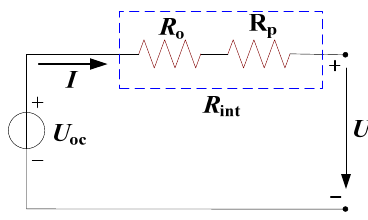
Figure 7. The Rint battery